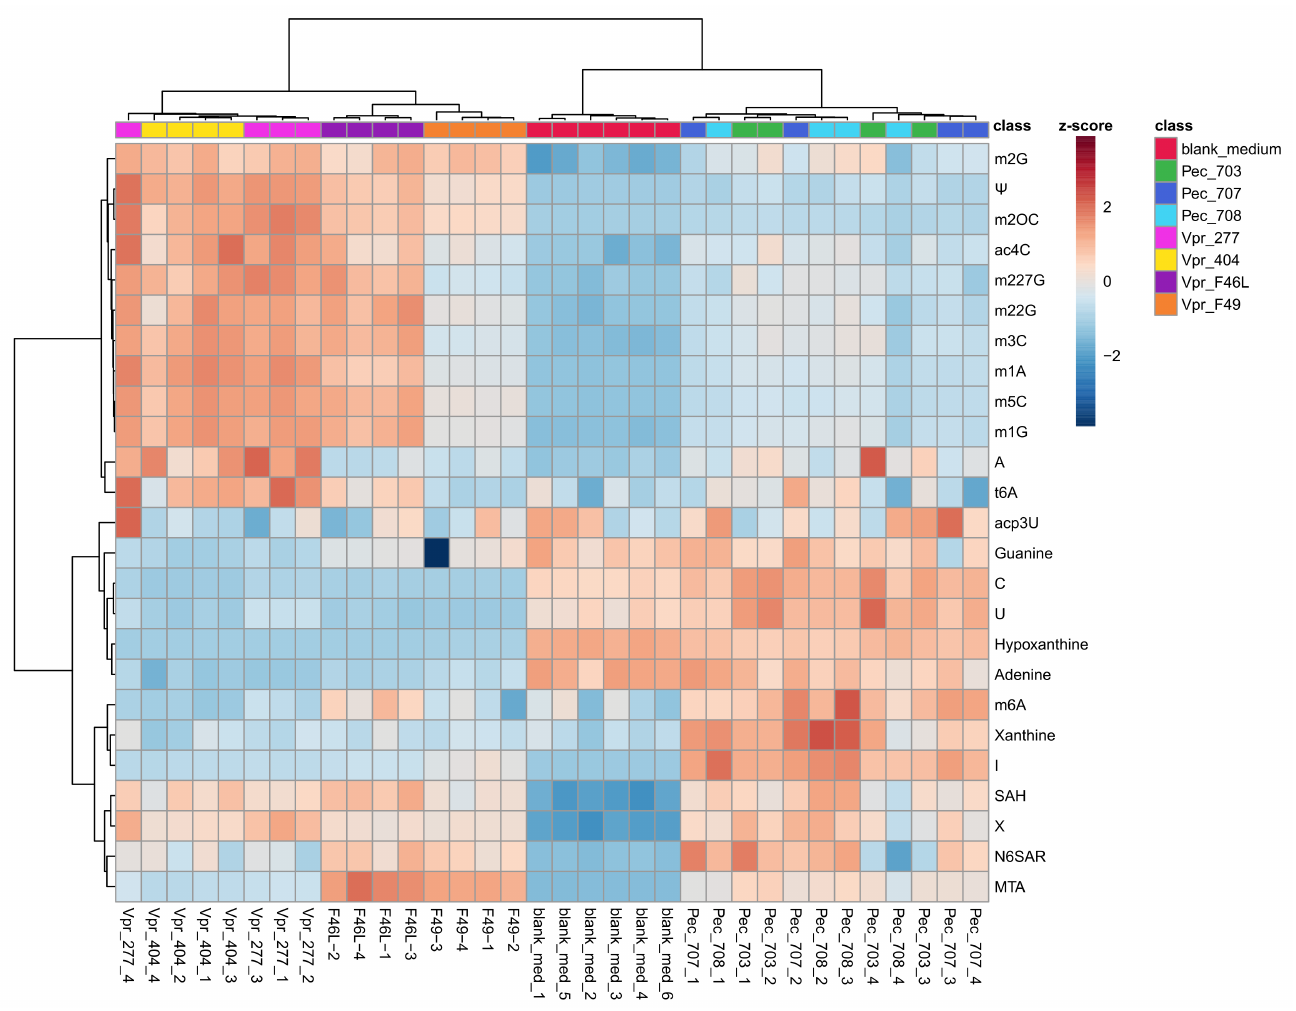
Figure 2. Heat map of the VPR, PEC cells and blank medium’s exometabolite profile. Rows refer to compounds and columns refer to biological samples. Three different PEC cell lines, four different VPR cell lines and the blank medium were analyzed. Only significantly altered metabolites (one-way ANOVA, corrected for multiple testing by FDR, q -value < 0.05) are displayed. The color scale on the right represents the range scaled z-score: redder tints refer to higher relative amounts and bluer tints refer to lower relative amounts of a respective metabolite in a biological sample. The clustering of the heat map demonstrates that the distances of the whole VPR group are greater than the distances between the PEC group and the blank control, which are clustered closer together. N = 4 for PEC and VPR, N = 6 for